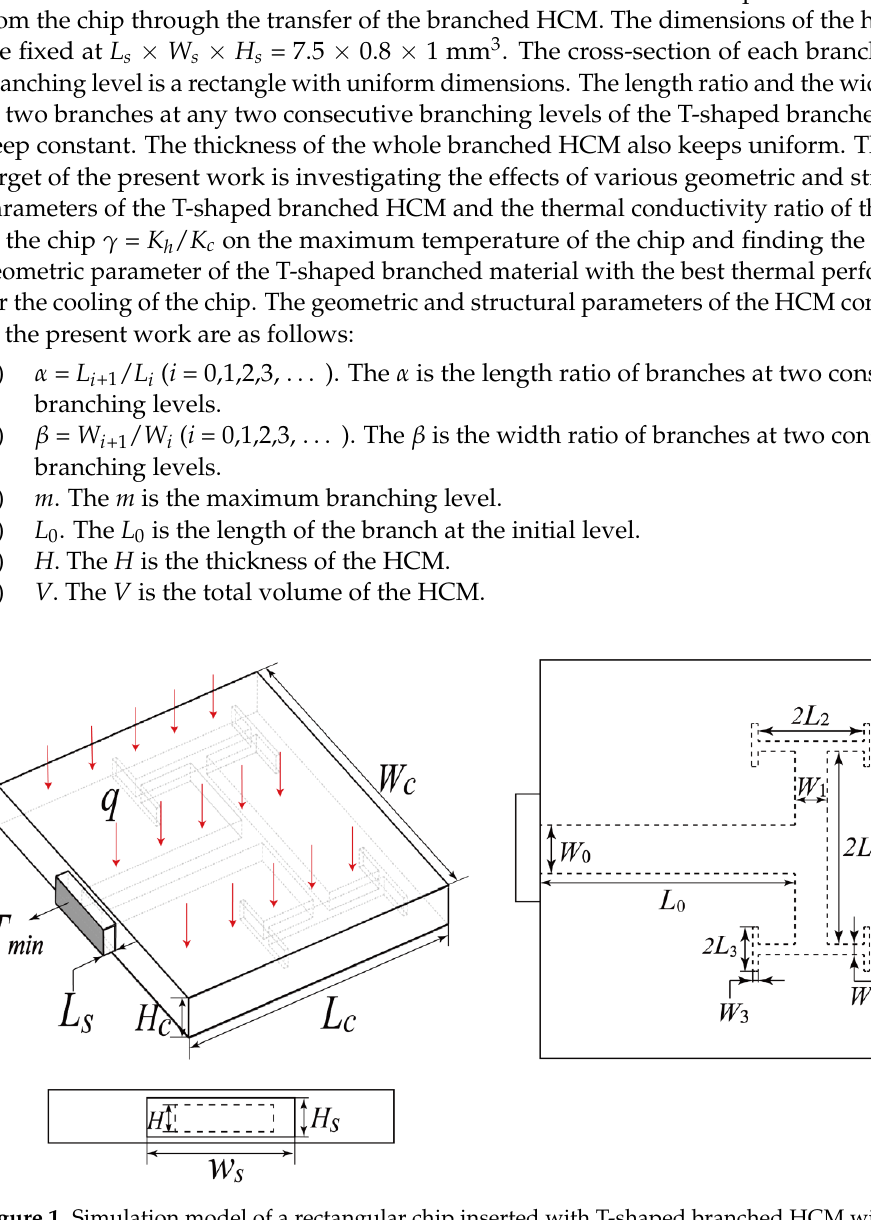
Figure 1. Simulation model of a rectangular chip inserted with T-shaped branched HCM with m =